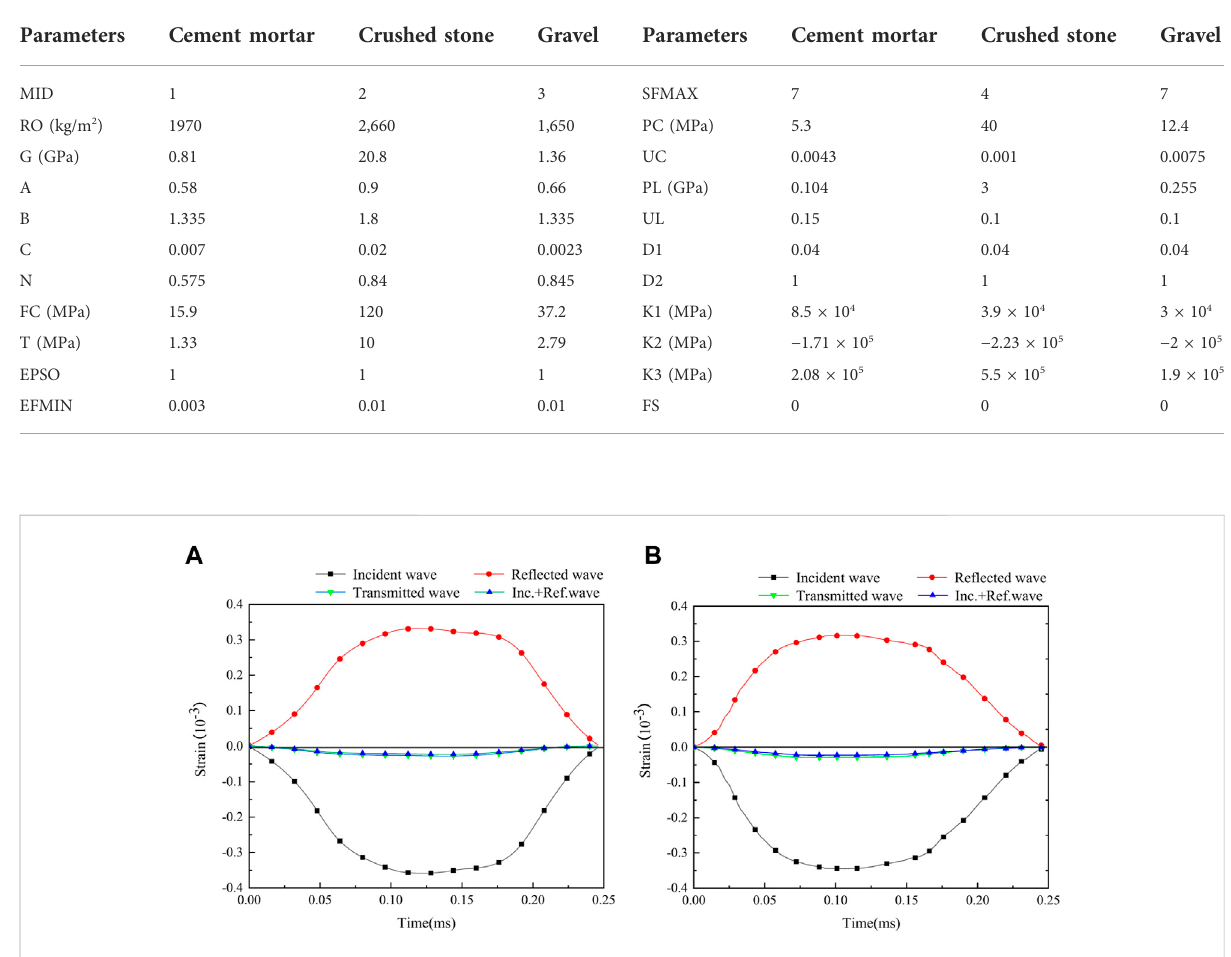
TABLE 4 Parameters of the HJC constitutive